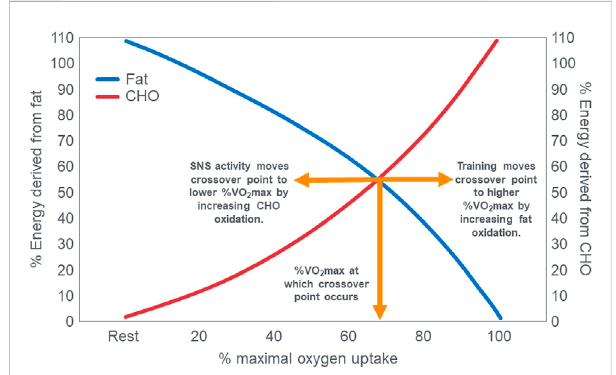
FIGURE 1 The relation between the relative contributions of fat and carbohydrate (CHO) utilization to overall energy expenditure as a function of exercise intensity. The point at which the two lines intersect illustrates the classic crossover concept. Reproduced and redrawn from (Brooks and Mercier, 1985; Kenney et al.,